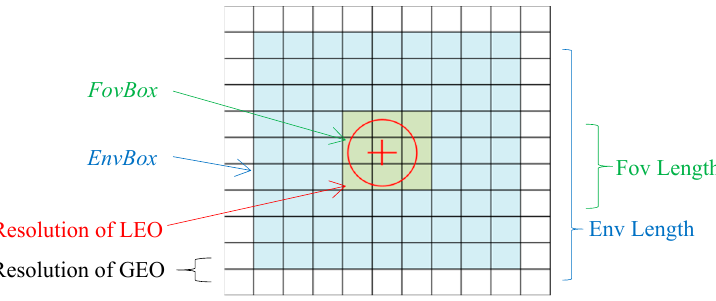
Figure 5. Conceptual diagram of FovBox and EnvBox .